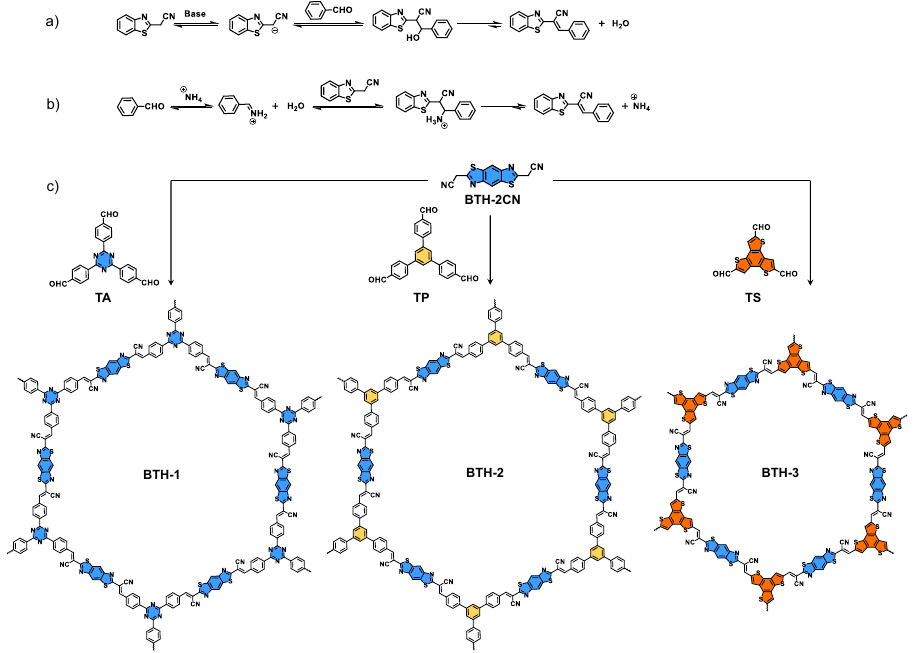
Fig. 1 Chemical structures. a , b Proposed mechanisms of Knoevenagel polycondensation at different conditions. c Synthetic routes and chemical structures of COFs BTH-1 , 2 , 3 .